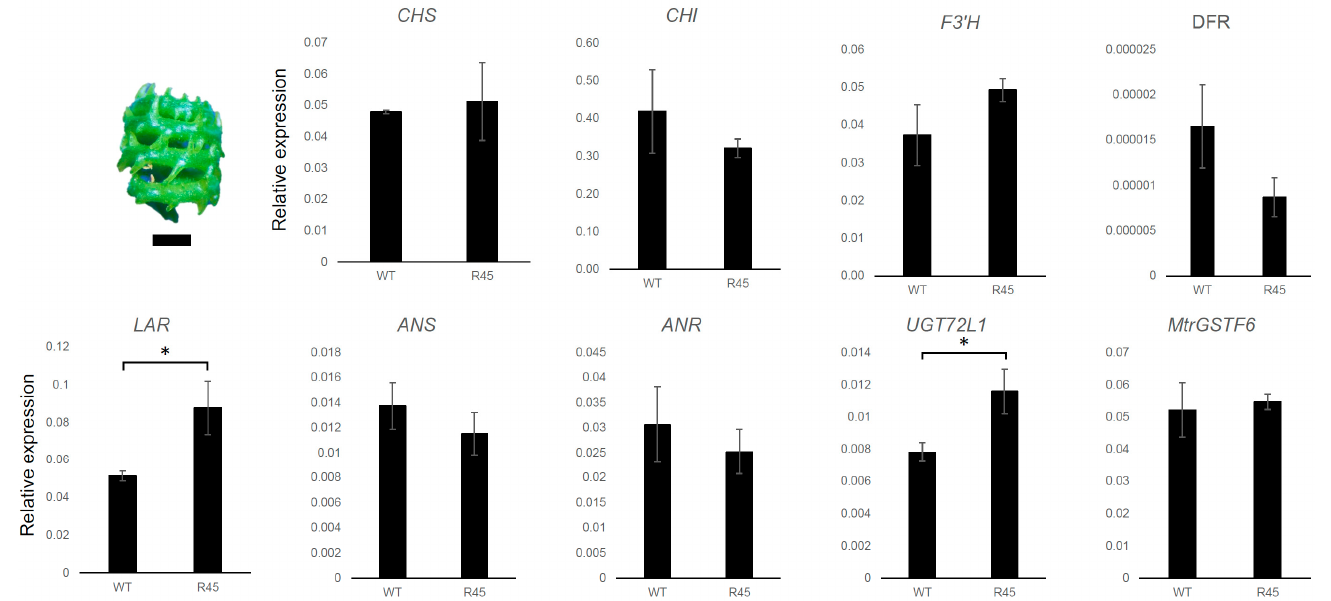
Figure 10. Gene expression in leaves of M. truncatula R108 (WT) vs. mutant plants (R45) grown in cold conditions. Expression levels are calculated as in legend of Figure 9 (* p < 0.05).